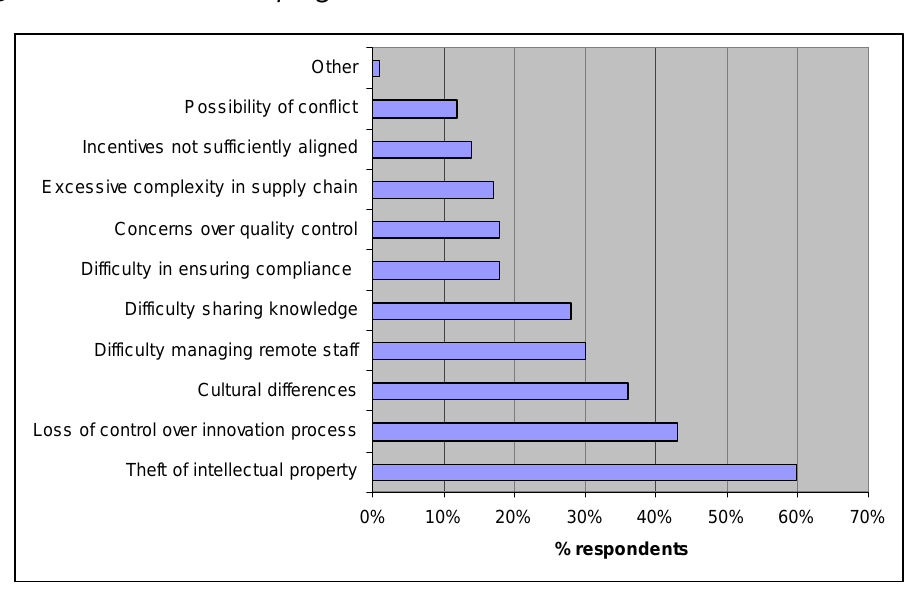
Figure 1: Risks in Developing Global Innovation